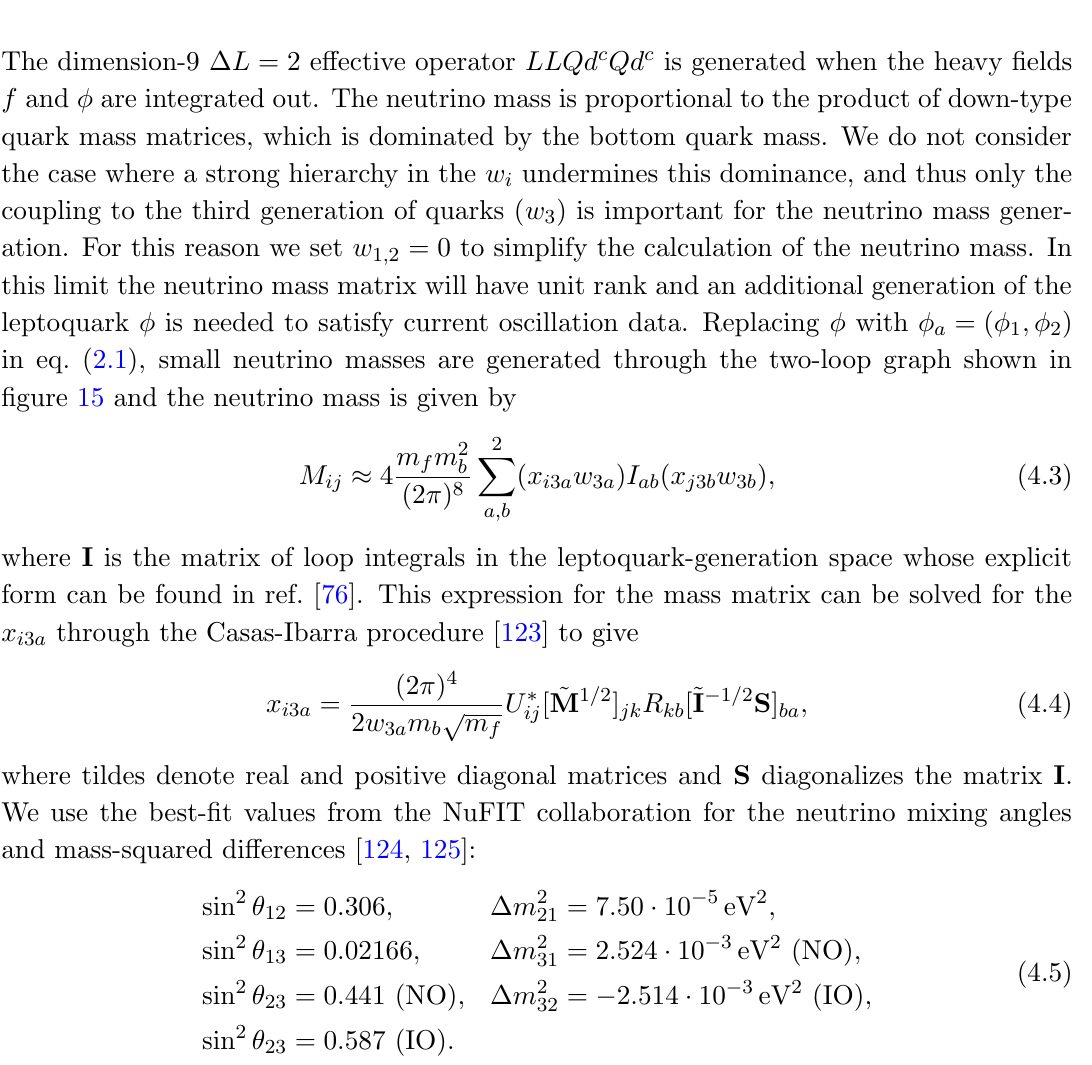
Figure 15. Two loop neutrino mass generation in the model of ref. [76]. For simplicity we consider the case where the leptoquark (cid:30) couples signi(cid:12)cantly only to the third generation of quarks. At least two (cid:13)avors of (cid:30) are required to meet the neutrino